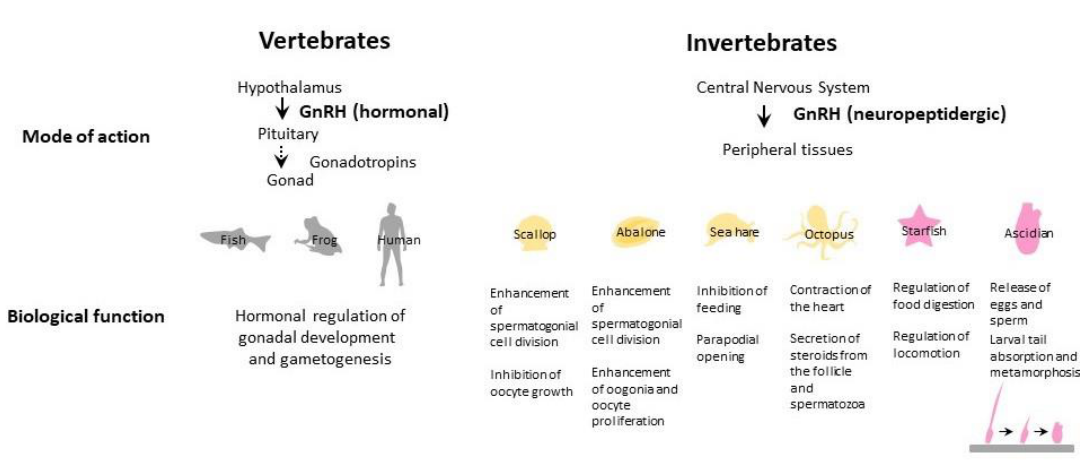
Figure 3. Major biological functions of GnRHs.